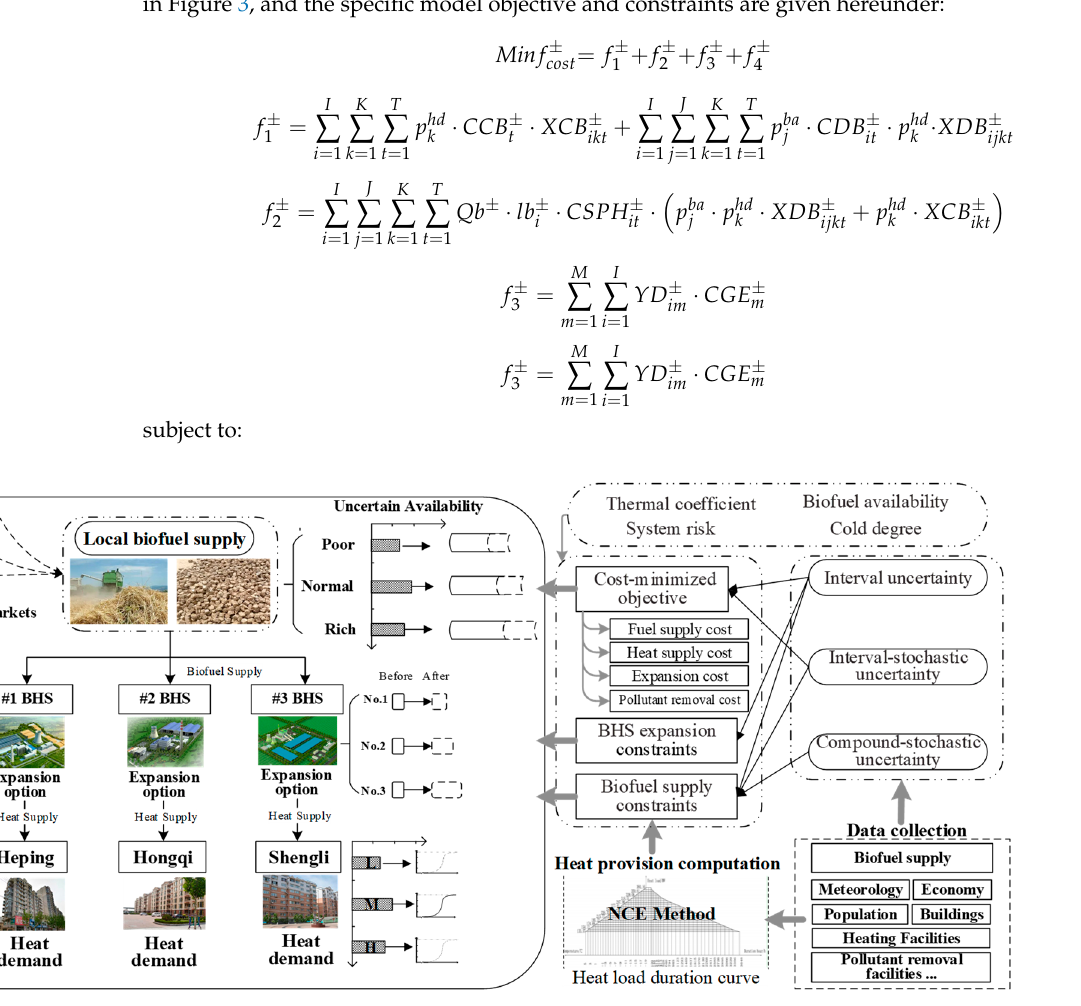
Figure 3. Modeling process for the investigated